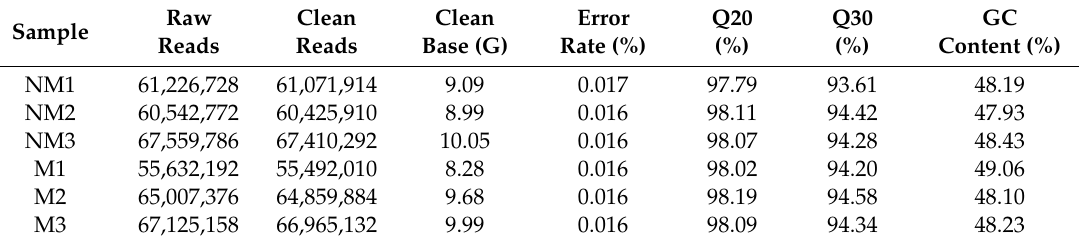
Table 1. Summary of the analysis of transcriptome sequences from the NM and M growth for six months.